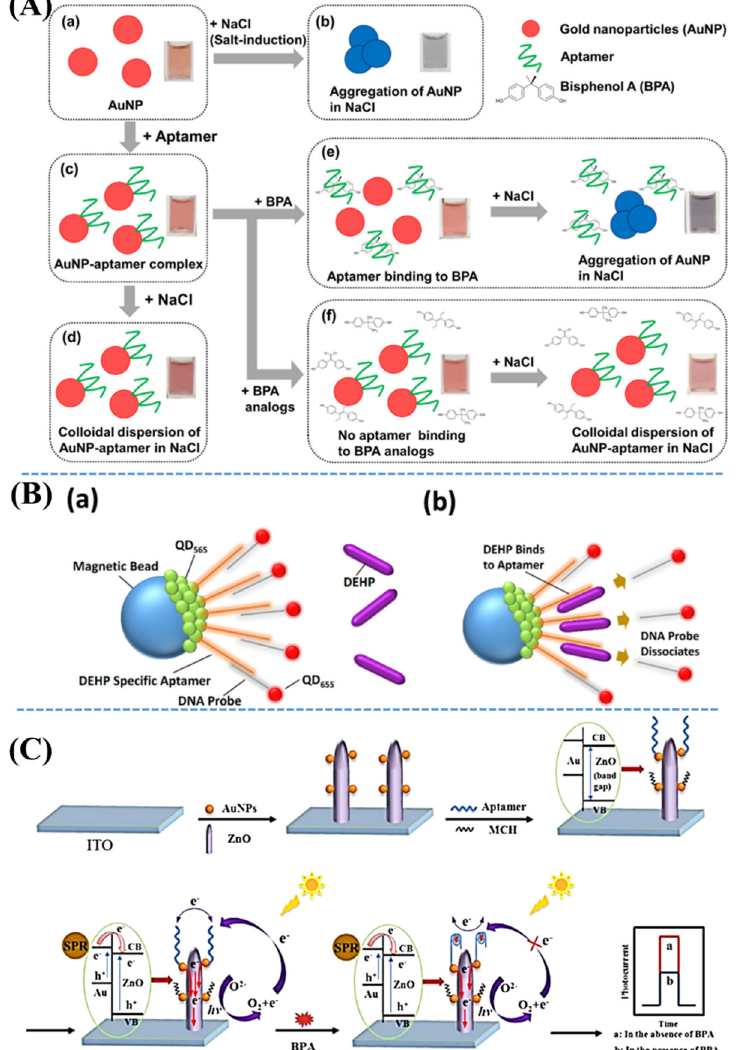
Figure 7. ( A ) Schematic illustration of colorimetric BPA detection based on an aptasensor using AuNPs. ( A – a ) AuNP solutions. ( A – b ) NaCl-induced AuNP aggregations. ( A – c ) aptamer addition leading to form AuNP-aptamer. ( A – d ) AuNP-aptamer is still well-dispersed after adding NaCl. ( A – e ) BPA presence inducing the binding between aptamer and BPA. Subsequent addition of NaCl resulting in the aggregation of AuNP-aptamer complexes. ( A – f ) Presence of BPA analogs leading to low binding affinity. Despite the addition of NaCl, AuNP-aptamer complexes are still dispersing well. Adapted from [82]. Schematic illustration of the quantum dot aptasensors ( B – a ) in the absence and ( B – b ) in the presence of DEHP. Adapted from [83]. ( C ) Diagram of the fabricated photoelectro- chemical aptasensors using AuNPs and ZnO nanopencils functionalized with BPA aptamers, which was aimed for BPA detection by means of the SPR technique. Adapted from [85].